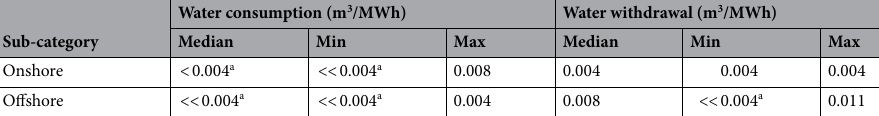
Table 15. Wind-generated power plant’s water withdrawal and consumption data 69 . a < 0.004 designates a value between 0.0003 and 0.002 (due to rounding), and << 1 designates a value less than 0.0003.